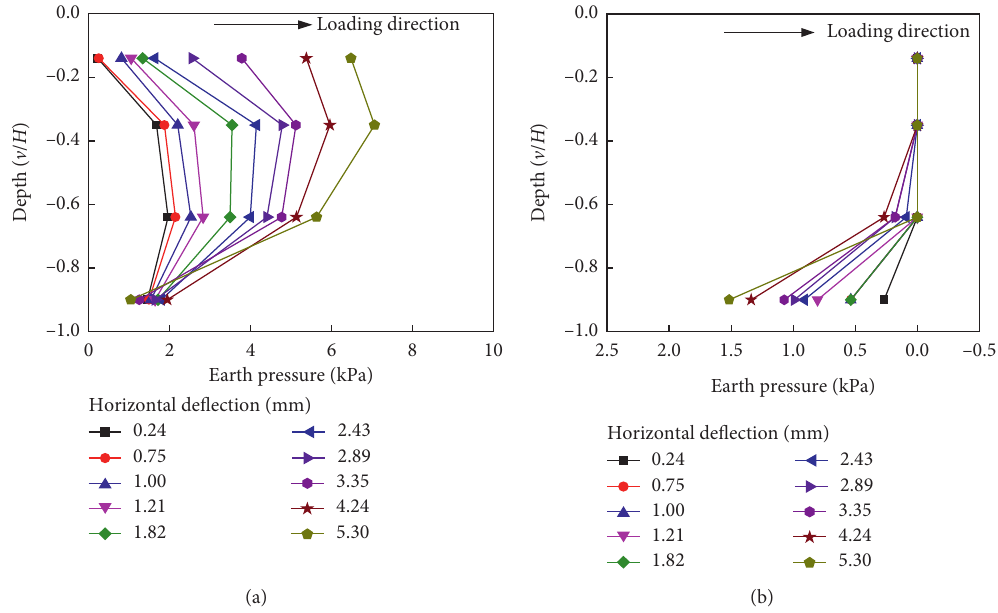
Figure 13: Distribution of earth pressure along CHFRF no. II-D. (a) In the loading direction. (b) Opposite the loading